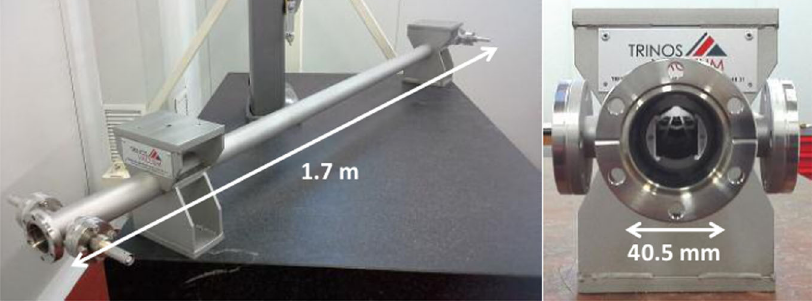
length.FIG. 19. Photograph of the striplines beam tube and feedthroughs (left), as well as a cross section detail showing the new half-moon electrode shape (right).